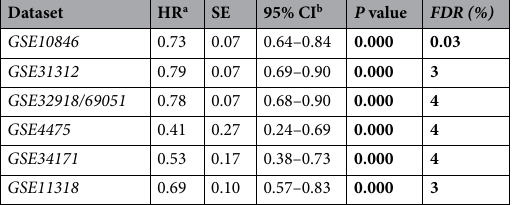
Table 1. Statistics of univariate Cox proportional hazard analysis of the RTN1 gene in the various datasets. Significant P values were bolded. a Hazard ratio, b Hazard ratio 95% confidence interval.